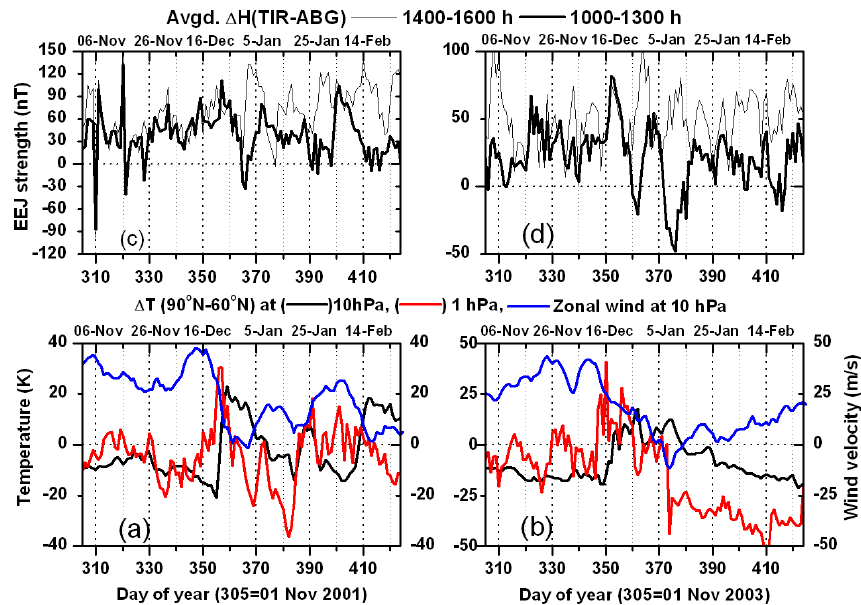
Fig. 3. Daily variation EEJ strength averaged for 10:00–13:00IST and 14:00–16:00IST ( c and d ) and state of high-latitude winter at 10hPa ( a and b ) for a time interval of 1–120 days starting 1 November 2001 and 1 November 2003.